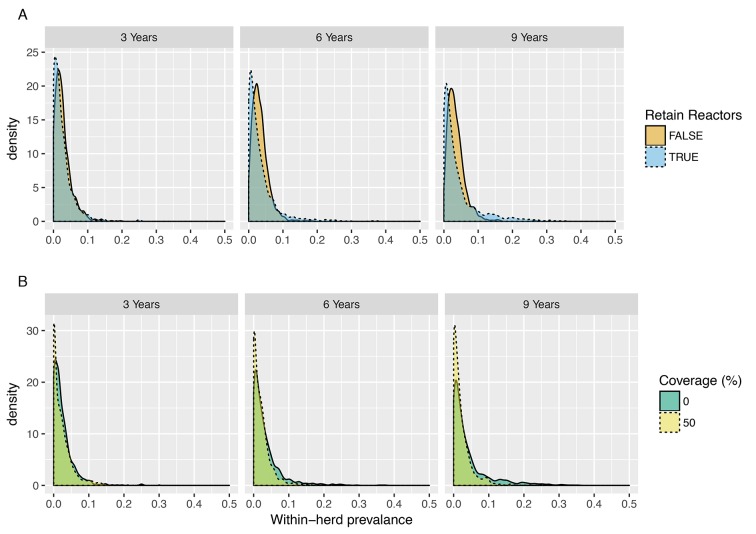
Posterior predictive distributions for within-herd prevalence for 3-, 6- and 9-year trial durations (SOR model).(A) Posterior predictive distributions for the proportion of reactors disclosed within a herd (within-herd prevalence) for trial-durations of 3, 6 and 9 years under policies where reactor animals are retained within herds (orange, FALSE) or removed when disclosed (blue, TRUE). Over a 3-year period, retention of reactors makes very little difference to the overall attack rate due to the relatively low transmission rates and long inter-generational period. (B) Posterior predictive distributions for the proportion of reactors disclosed within a herd (within-herd prevalence) for trial-durations of 3, 6 and 9 years in unvaccinated (0% coverage, Blue) and partially vaccinated (50% coverage, Yellow) herds for the most optimistic scenario of an assumed reduction in susceptibility and infectiousness oεS,εI=90%. Even for this most optimistic scenario, a 50% coverage of vaccination is predicted to have very little impact on within-herd transmission for trial-durations of up to 9 years.